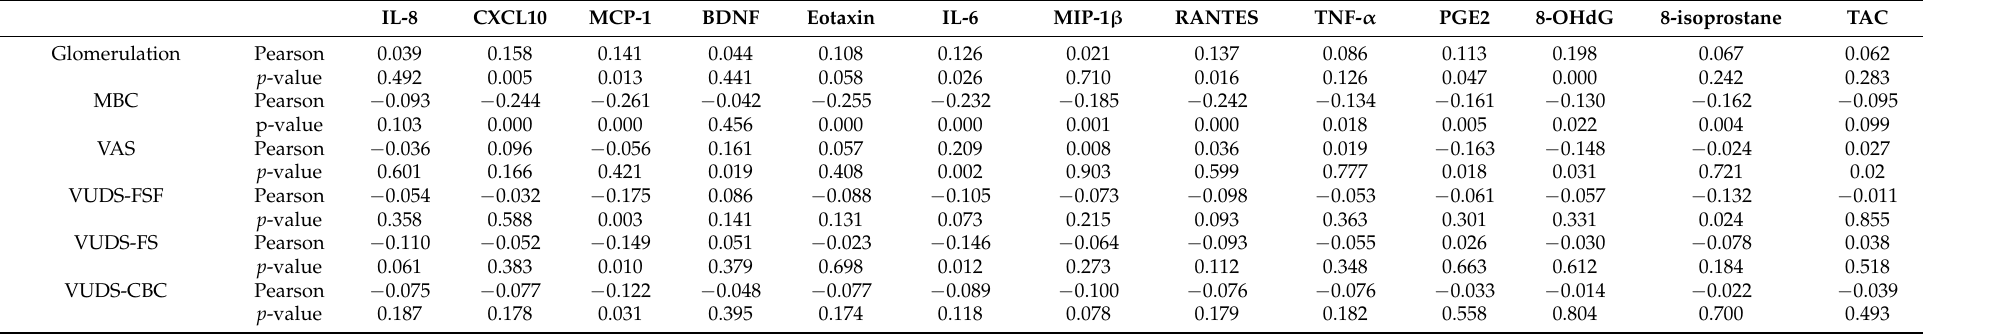
Table 4. Correlation analysis of the association between urine biomarker level and bladder characteristics of IC/BPS patients.